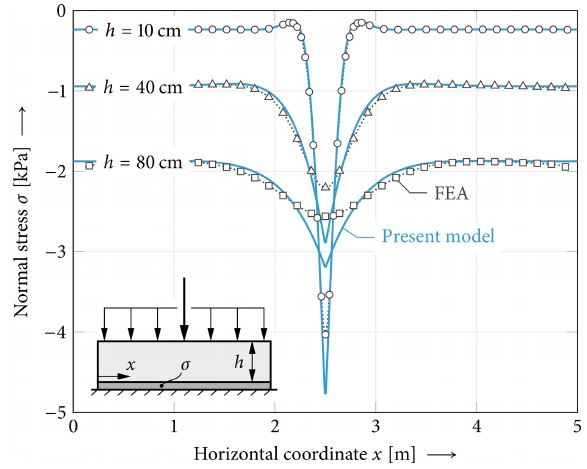
Figure 6. Normal and shear stresses owing to pure vertical and pure horizontal combined skier and slab weight loading, respec- tively. Comparison of the present model (blue) and the Föhn (1987) model (red) to FEA results (circles). Model parameters other than h = 20cm, t = 1cm, E slab = 5MPa, E weak = 0 . 15MPa and ρ = 200kgm − 3 are chosen as given in Fig. 1.